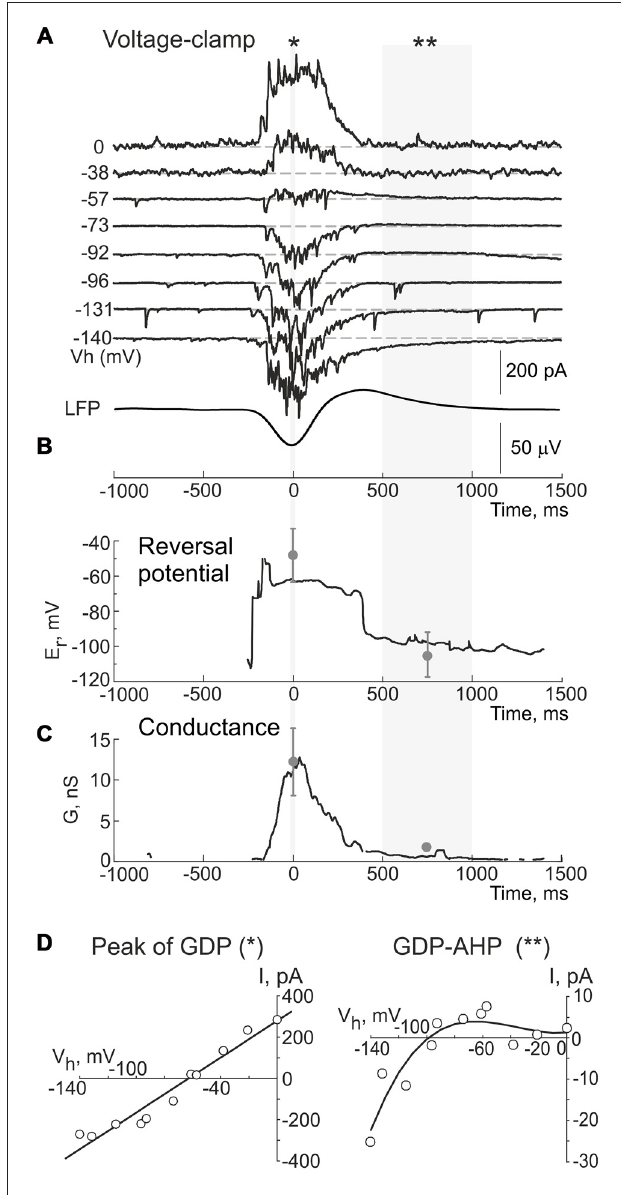
FIGURE 5 | Dynamic changes in the reversal potential of the conductance activated during GDPs and GDP-AHP in a CA3 pyramidal cell. (A) Example traces of the currents recorded using gramicidin perforated patch at different holding potentials during GDPs in a CA3 pyramidal cell from a P5 rat. Events are aligned against the troughs of field GDPs (bottom trace). (B) Reversal potential and (C) conductance of the currents during GDPs in the cell shown in (A) . Gray circles and error bars indicate mean ± SD obtained in seven cells. (D) Current-voltage relationships of the currents at the peak of GDPs (left, for a period indicated by asterisk in (A) , and during the GDP-AHP phase (right, for a period indicated by two asterisks in (A) . Note that a reversal potential of the conductance during the GDP-AHP phase is close to the potassium equilibrium and that it displays an inward rectification upon